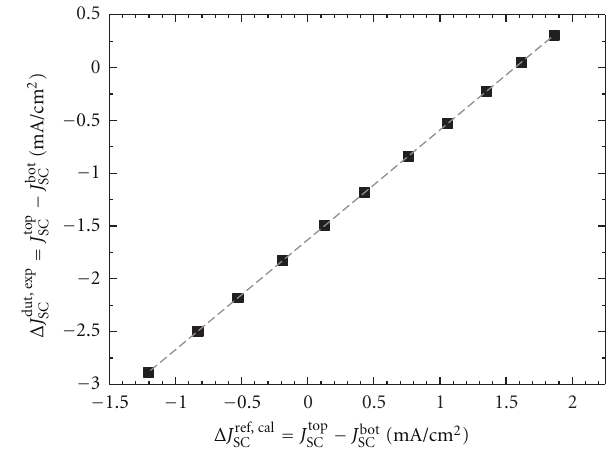
F 10: With an additional measurement of the external quan- F 8: e normalized output parameters, maximum output tum efficiency of the test cell and acquisition of the experimental test are power , �ll factor FF, and short-circuit current density SC spectra, the short-circuit current of the subcells of the test tandem given as determined for the reference tandem under calibration sample under test illumination (dut, exp) can be calculated. e illumination (ref, cal, same data as Figure 6, �lled symbols). e 𝐽𝐽𝐽𝐽 same data acquired under the experimental test illumination was relationship of the differences shiedtomatchthedataundercalibrationconditions(ref,exp,open the short-circuit currents for the reference under calibration illumi- symbols). e data overlap. e axis is the one from the calibration nation is measurement. 𝑥𝑥𝑥𝑥